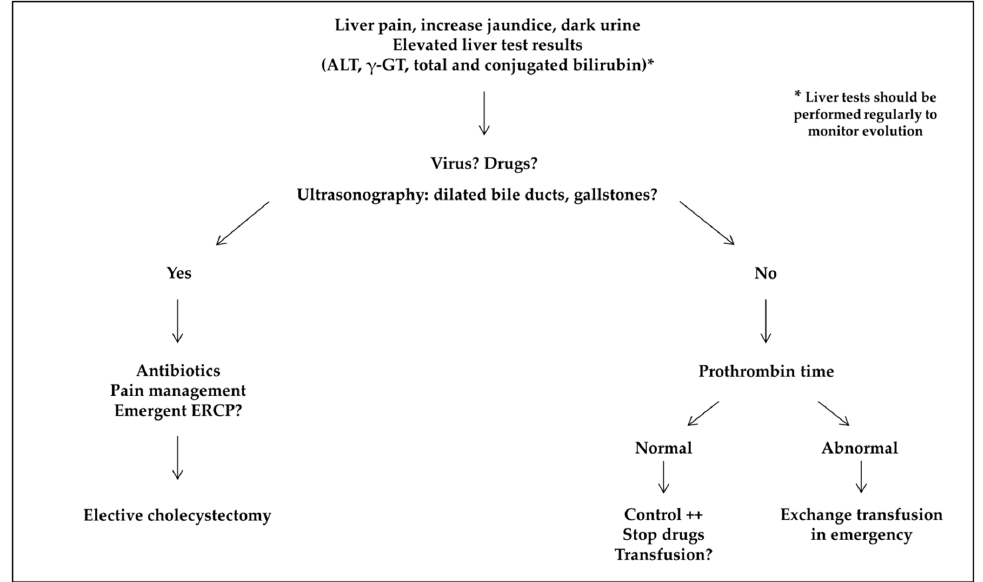
Figure 3. Screening for acute hepatobiliary complications. ALT: alanine aminotransferase; ERCP: endoscopic retrograde cholangiopancreatography; γ -GT: gamma-glutamyltransferase.